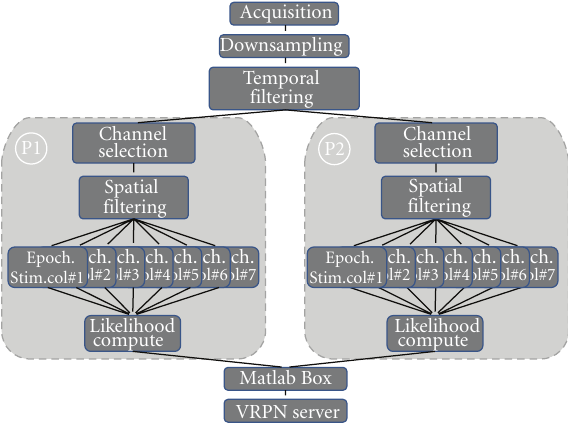
Figure 3: OpenViBE scenario of the BCI “Connect